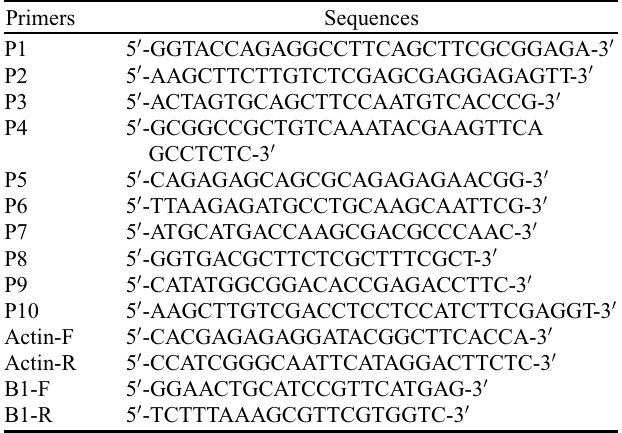
Table 1. Primers used in this study.